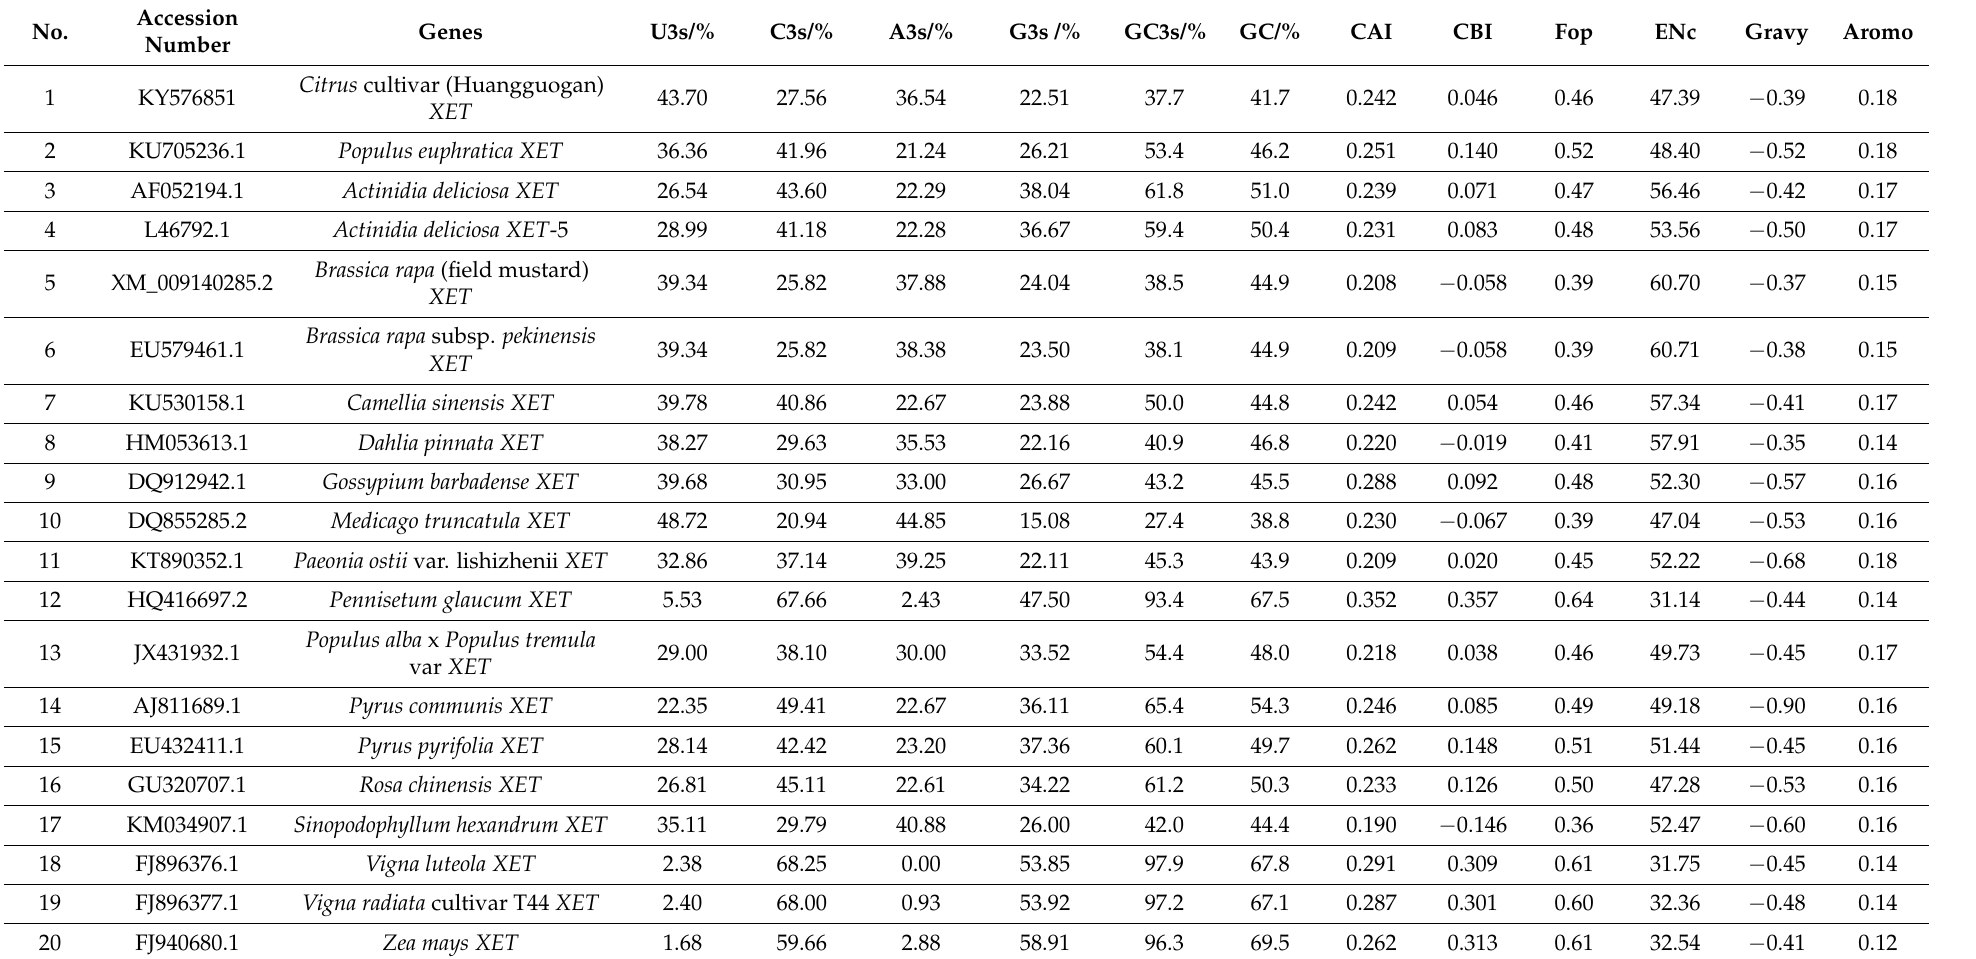
Table 1. Accession numbers and characteristics of the analyzed XET coding